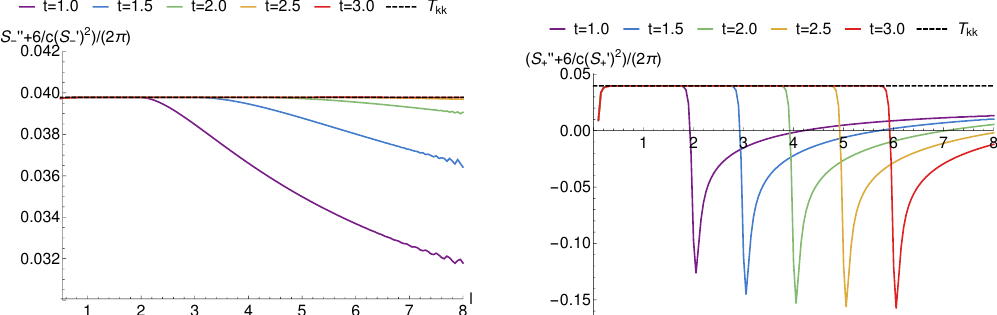
= 1 M ( t ) and the kk 8 π µ ∝ ( 1, − 1 ) ) as a function −